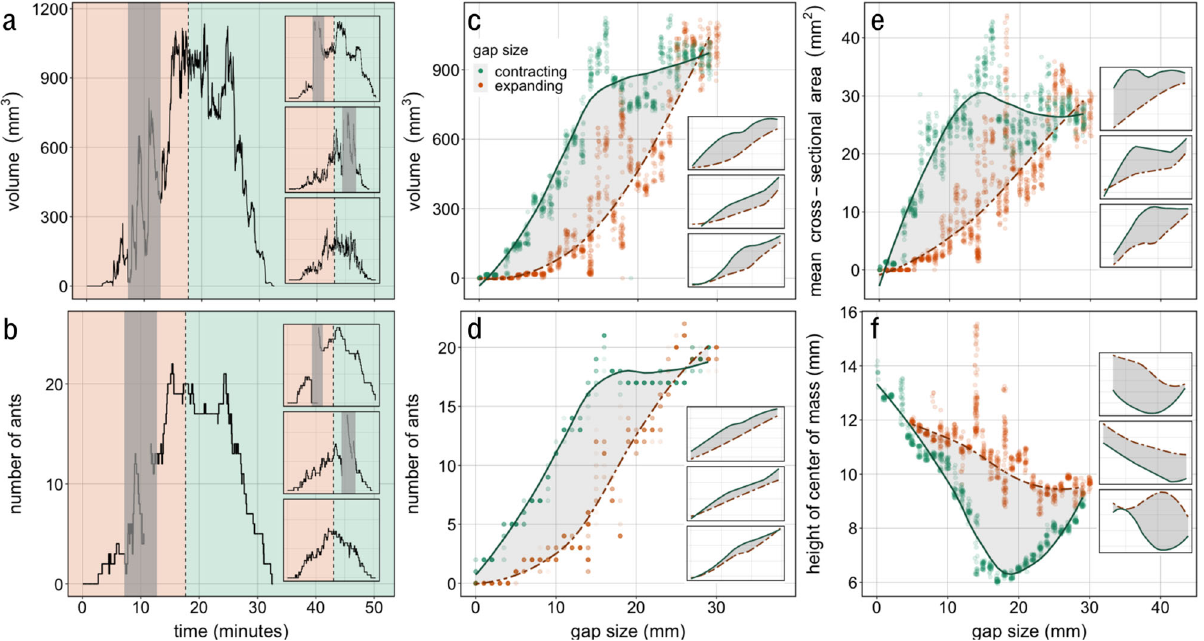
Fig. 2 Changes in collective structures in experiments. a , b Volume and group size of self-assembled bridges: a Estimated volume of collective bridge structures over time for one focal trial (main fi gure) and three other examples (inset). The dotted vertical line indicates the time when the experiment shifted from the expansion phase (increasing gap size) to the contraction phase (decreasing gap size). Gray shading indicates that the bridge was broken or recovering from a break; result metrics may be inaccurate during these periods and they were, therefore, excluded from analyses. b The number of ants in the bridge structure over time for the same focal trial (main fi gure) and three other examples (inset). c – f Hysteresis: Trials consistently show hysteresis, with bridge status at a particular gap size differing during the expansion and contraction phases, for volume ( c ), number of ants ( d ), mean cross-sectional area ( e ), and tautness, or the height of the center of mass of the bridge from the side view ( f ; lower values indicate bridge is hanging lower). c – f Panels show result metrics over gap size for the same focal trial as in panels a and b , as well as for three other examples (inset). Points show individual measurements, taken every second, lines are smoothed LOESS (local regression) for the expansion (orange points, dashed orange line) and contraction (green points, solid green line) phases. The area between the smoothed lines (shaded gray) shows the extent of hysteresis. c , e , f ) Points are jittered to improve clarity. a – f See Supplementary Figs. 2, 3, 5 – 8 for all complete